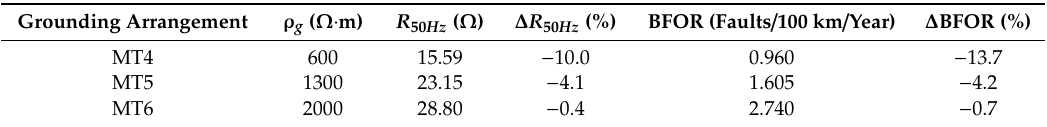
Countermeasure 3: improvement of the lightning performance for di ff erent soil resistivity